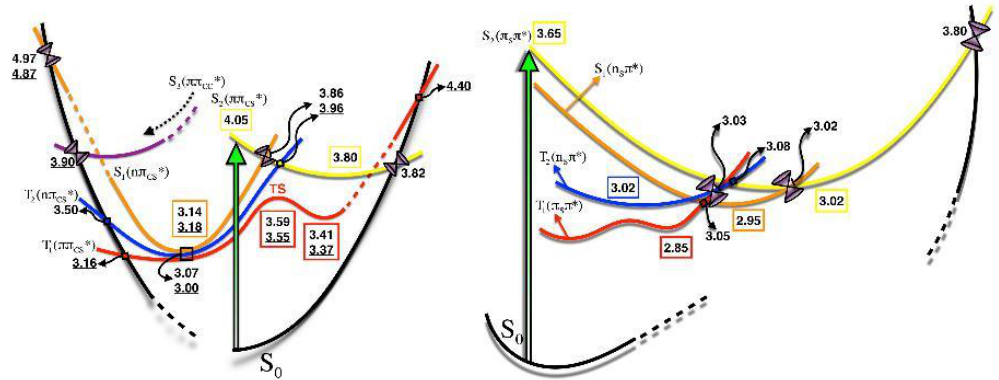
Molecules 2017 , 22 , 998 6 of